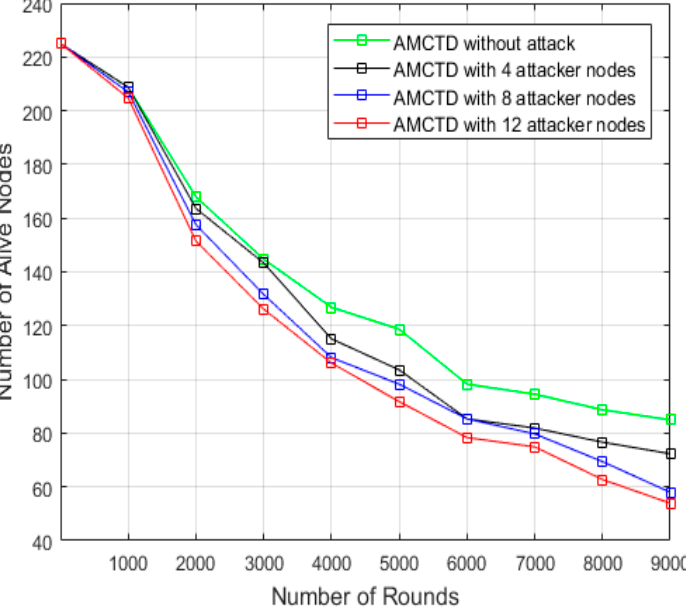
Figure 4. AMCTD: No. of Functioning/Alive Nodes Without attack and with 4, 8 and 12 Attacker Nodes.